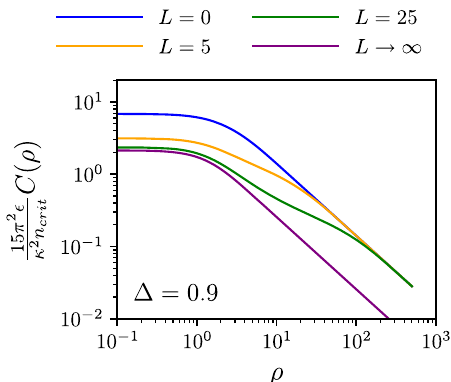
FIG. 3. The spatial correlation function C ð ρ Þ as a function of the distance ρ for Δ ¼ 0 . 9 and various values of L . At sufficiently large distances, C ð ρ Þ recovers the shaker behavior, while at small distances, correlations are suppressed by swimming. Note that the L → ∞ line, serving as the limit beyond which correlations cannot be suppressed, joins the shaker line at ρ → ∞